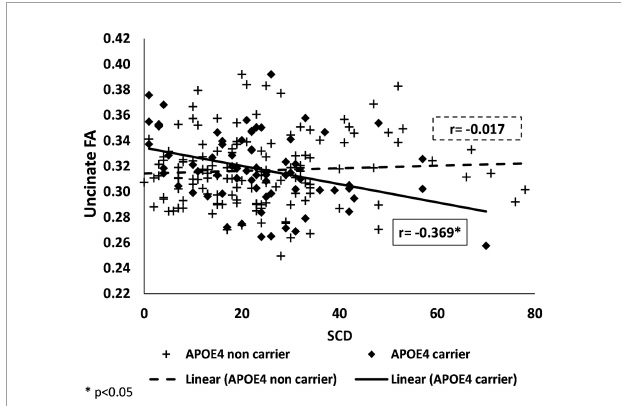
FIGURE3 Associations of SCD with fractional anisotropy in APOE ε 4 carriers and non-carriers. Negative association between FA and SCD among APOE ε 4 carriers (shown as black) and no association among APOE ε 4 non-carriers (shown as a dashed-line) in the uncinate fasciculi. SCD, subjective cognitive decline; APOE ε 4 , apolipoprotein E, alleles ε 34 or ε 44; FA, fractional